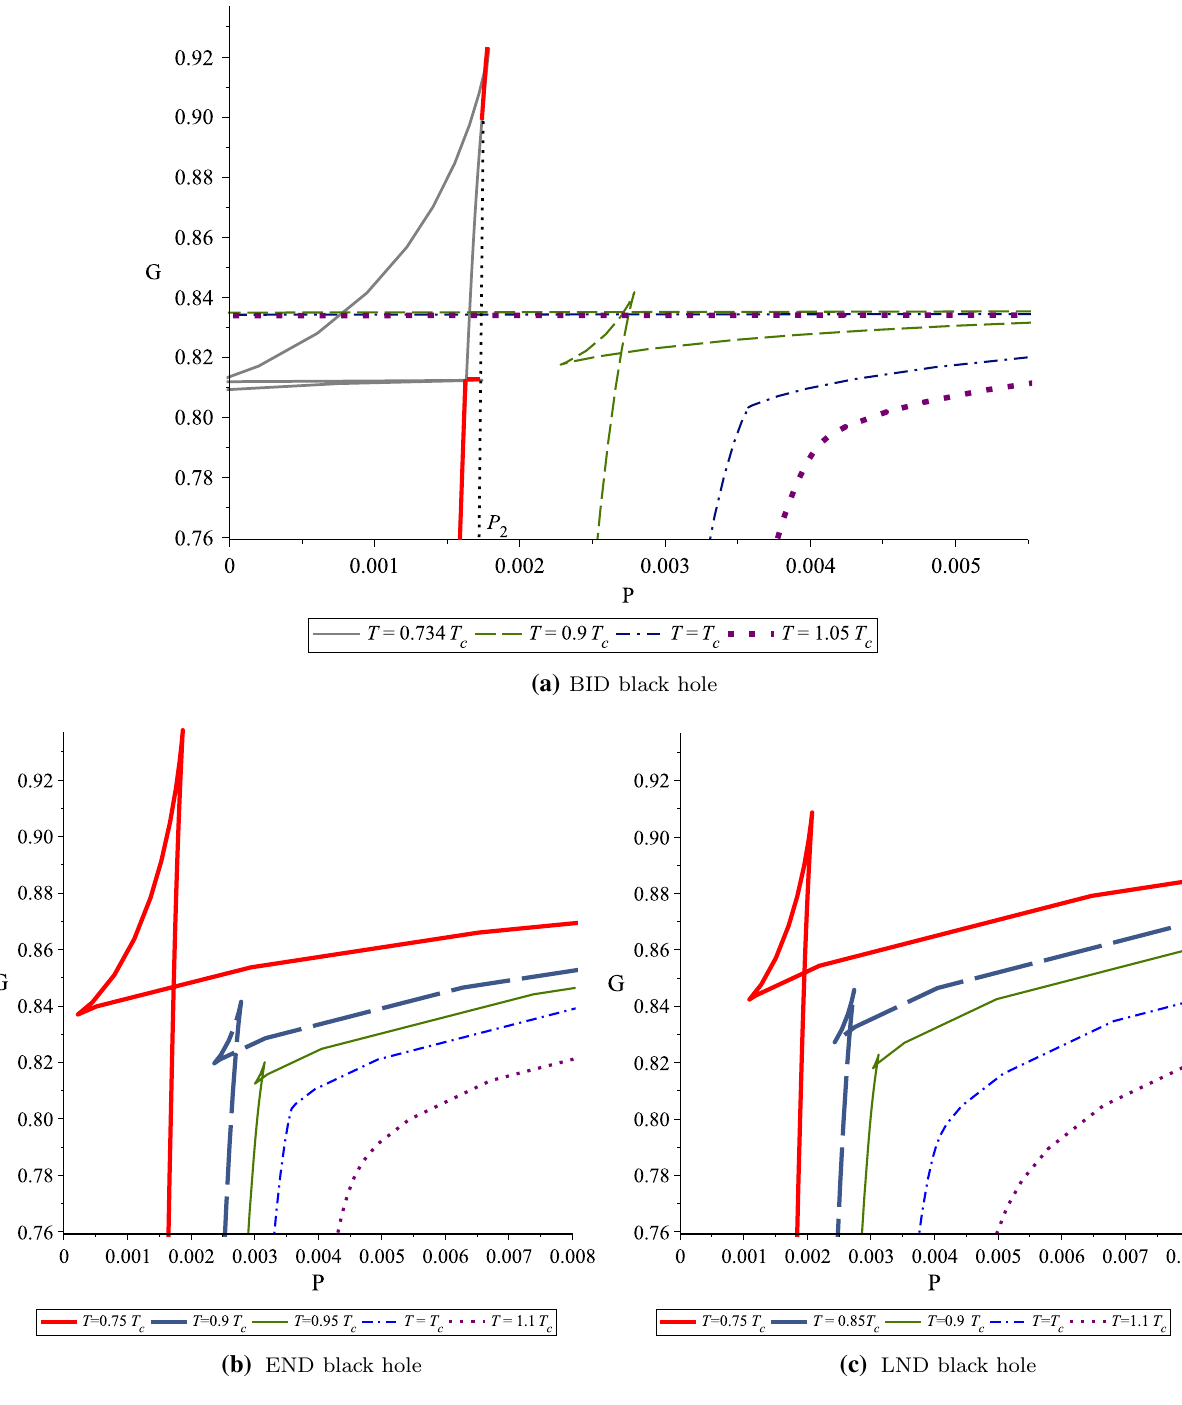
Fig. 13 Gibbs free energy versus pressure for α = 0, β = 0 . 45 and q = k = b =